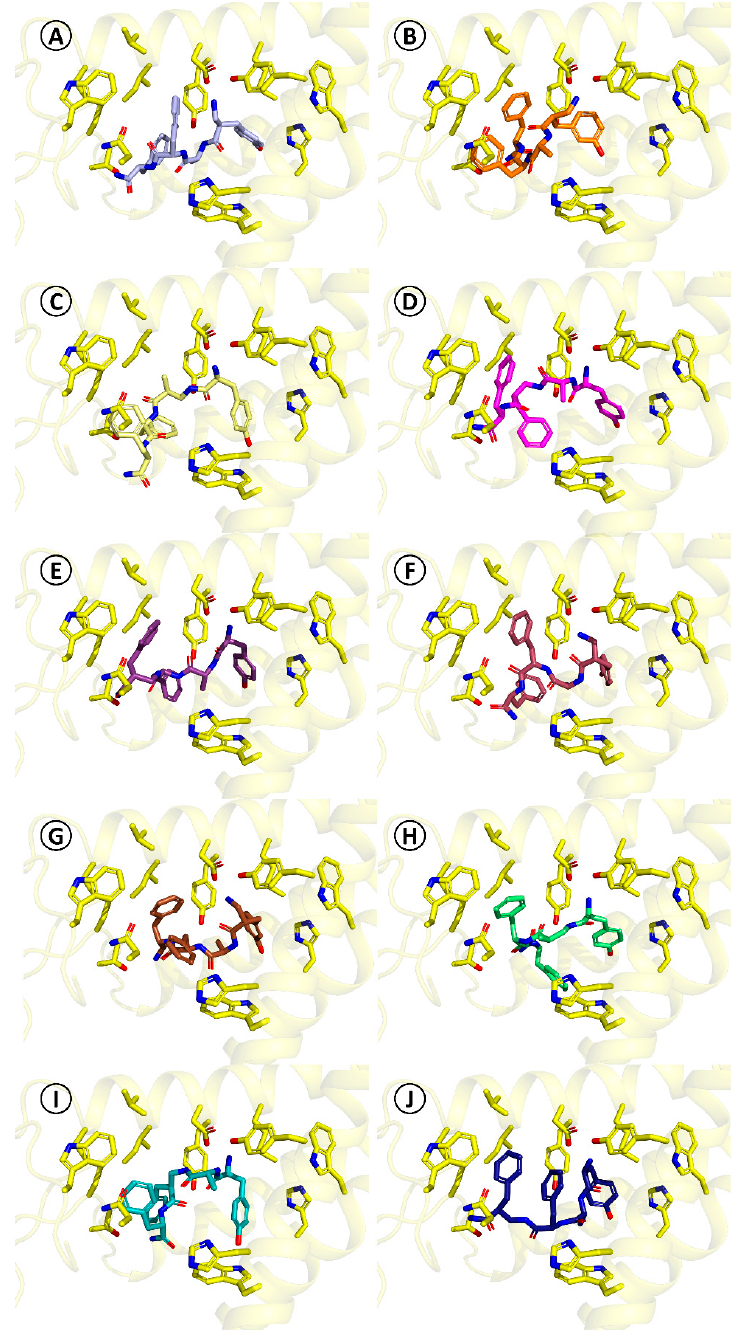
Figure 4. Binding modes of compounds 8 – 17 as predicted by docking. The pictures are oriented in the same projection as Figure 2. Only several side-chains of the receptor binding site (yellow sticks) are shown. ( A ) [( R )- β 2 hTyr 1 ]-TAPP*, 8 , ( B ) [( R )- β 2 h- m -Tyr 1 ]-TAPP*, 9 , ( C ) [( S )- β 2 hAla 2 ]-TAPP, 10 , ( D ) [( R )- β 2 hPhe 3 ]-TAPP, 11 , ( E ) [( R )- β 2 hPhe 4 ]-TAPP, 12 , ( F ) [( S )- β 2 hTyr 1 ]-TAPP*, 13 , ( G ) [( S )- β 2 h- m -Tyr 1 ]-TAPP*, 14 , ( H ) [( R )- β 2 hAla 2 ]-TAPP, 15 , ( I ) [( S )- β 2 hPhe 3 ]-TAPP, 16 , ( J ) [( S )- β 2 hPhe 4 ]-TAPP, 17 .